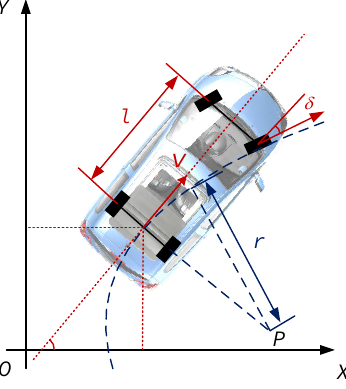
Figure 9. Ackermann vehicle model. l is the vehicle wheel base. v is velocity of rear axle center. δ is the tire angel. P is the instantaneous center of